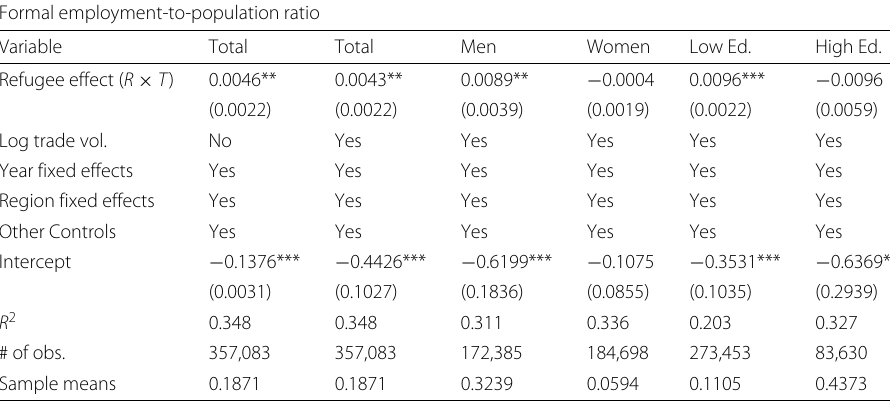
Table 8 Formal Employment-to-population ratio Formal employment-to-population